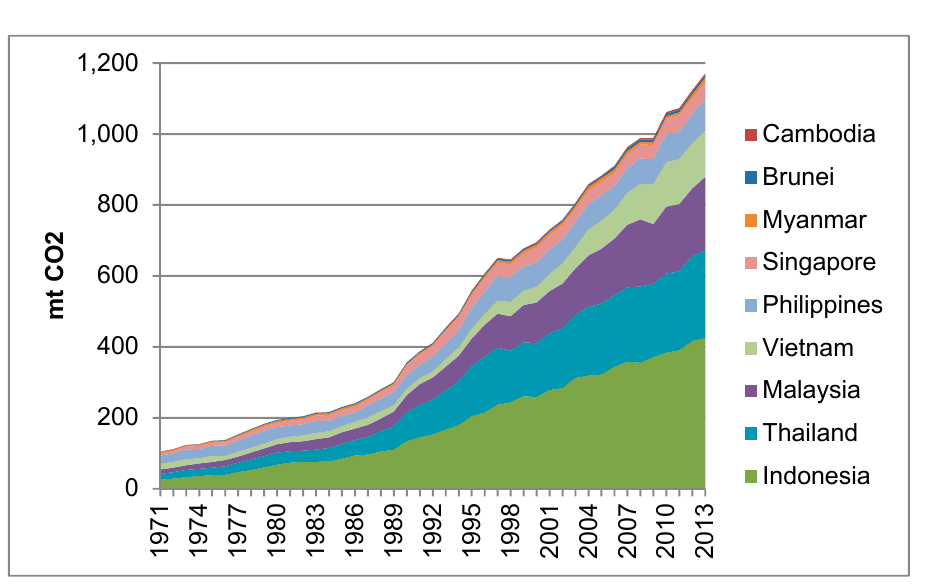
Figure 3. CO 2 emissions in ASEAN countries (calculated from IEA database 2015).